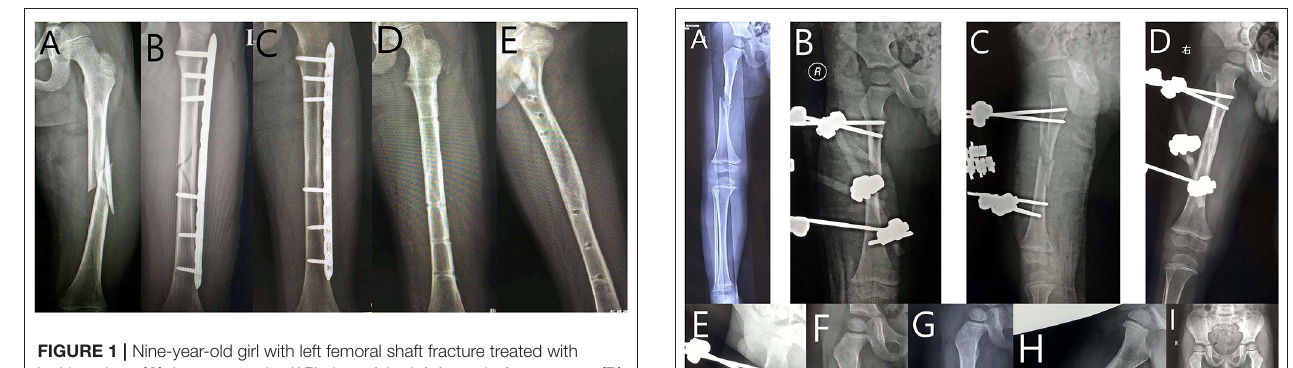
FIGURE 1 | Nine-year-old girl with left femoral shaft fracture treated with locking plate. (A) Anteroposterior (AP) view of the left femur before surgery. (B) AP view of the left femur after surgery. (C) AP view of the left femur at 9-month follow-up. (D) AP view of the left femur after hardware removal. (E) Lateral view of the left femur after hardware removal.